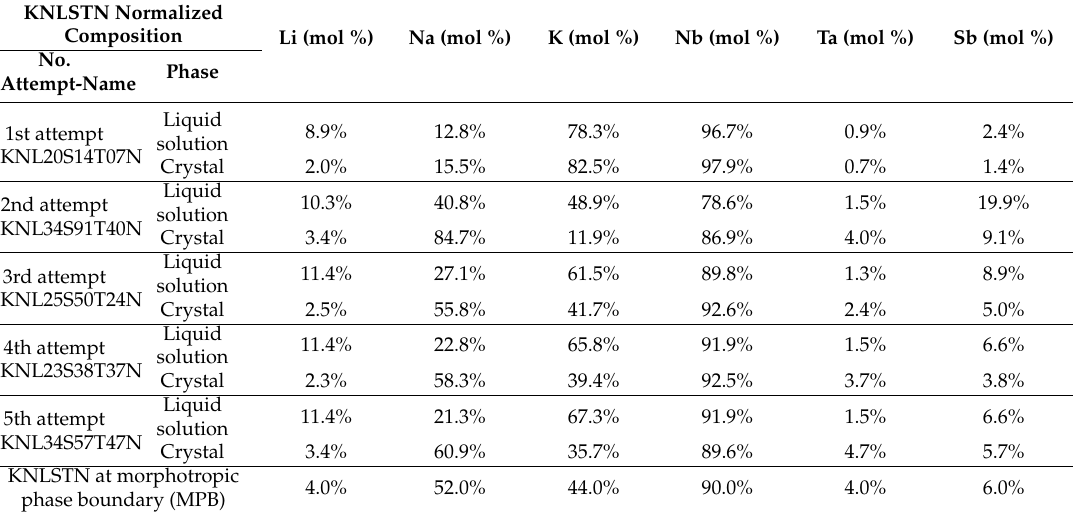
Table 2. Normalized liquid and crystal compositions of (Li x Na 0 . 52 K 0 . 48 ´ x )(Nb 1 ´ x ´ y Ta x Sb y )O 3 (KNLSTN) growth attempts.